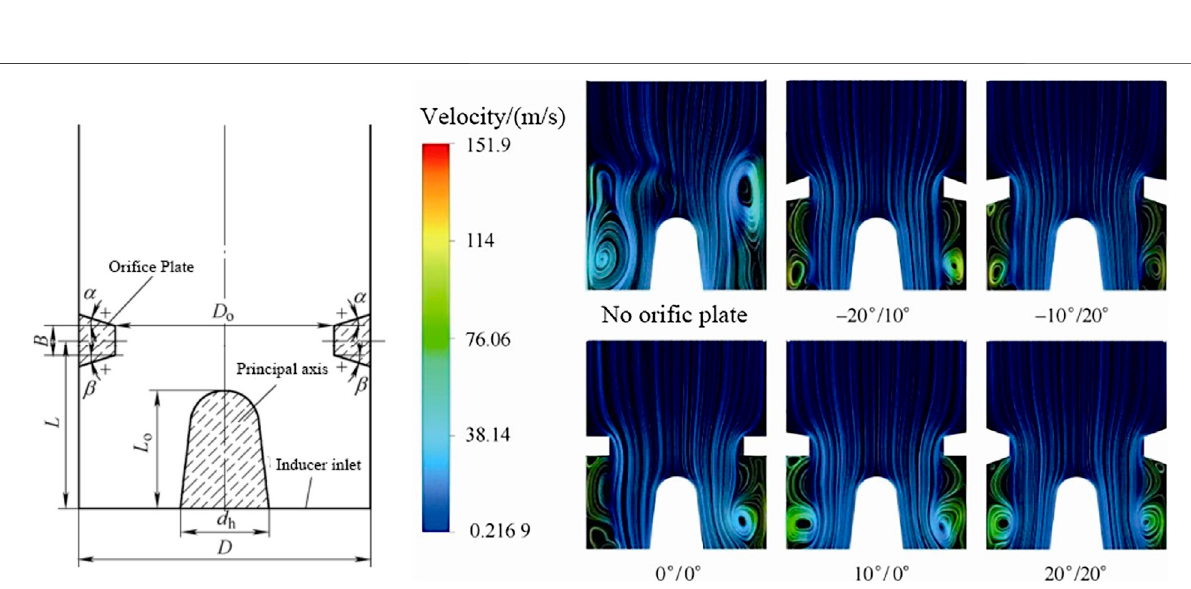
Frontiers in Energy Research |